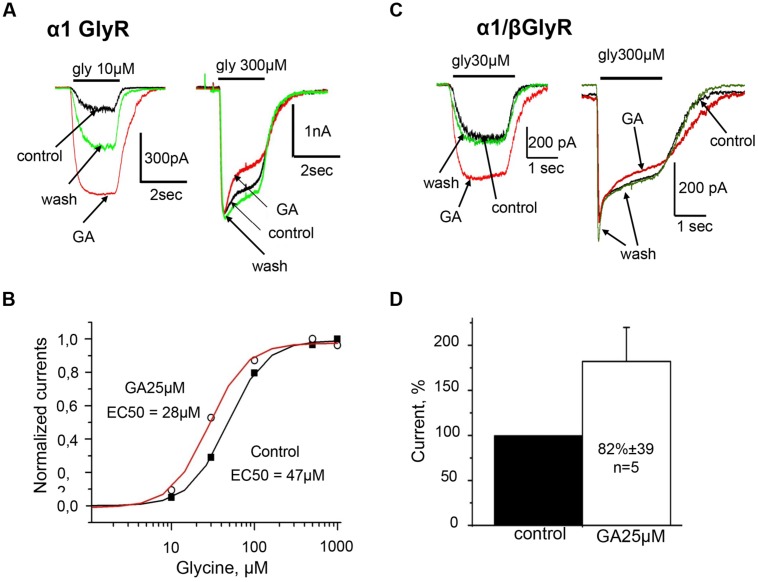
Homomeric α1 and heteromeric α1/β GlyRs are similarly potentiated by ginkgolic acid.
(A) Superimposed traces of whole-cell glycine-evoked currents induced by low (10 μM; left) and high (300 μM; right) concentrations of glycine, in control (black), after ginkgolic acid application (25 μM) (red) and after washout (green). Symmetrical CsCl pipette solution, Vh = –30 mV. (B) Ginkgolic acid causes reduction in EC50 for glycine. Representative dose–response curve for glycine in control (black squares) and during application of 25 μM ginkgolic acid (open circles). (C) Superimposed traces of whole-cell glycine-evoked currents induced by low (10 μM; left) and high (300 μM; right) concentrations of glycine, in control (black), after ginkgolic acid application (25 μM) (red) and after washout (green). Recording from the cell expressing heteromeric α1/β GlyRs. Symmetrical ‘CsCl’ pipette solution, Vh = –30 mV. (D) Cumulative data. Mean percentage of α1/β GlyR-mediated current potentiation after treatment with ginkgolic acid (25 μM).